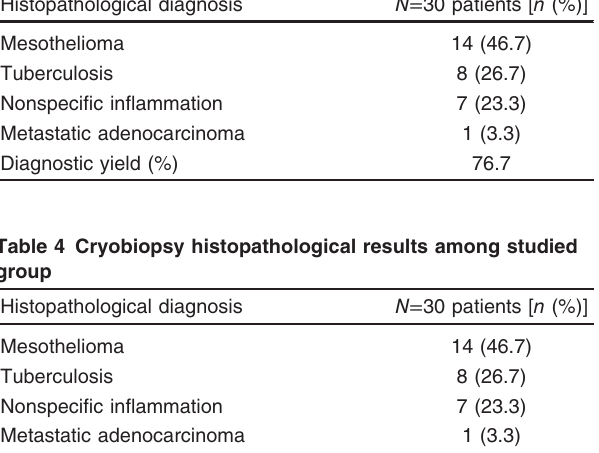
Table 3 Rigid forceps biopsy histopathological results among studied group Histopathological diagnosis